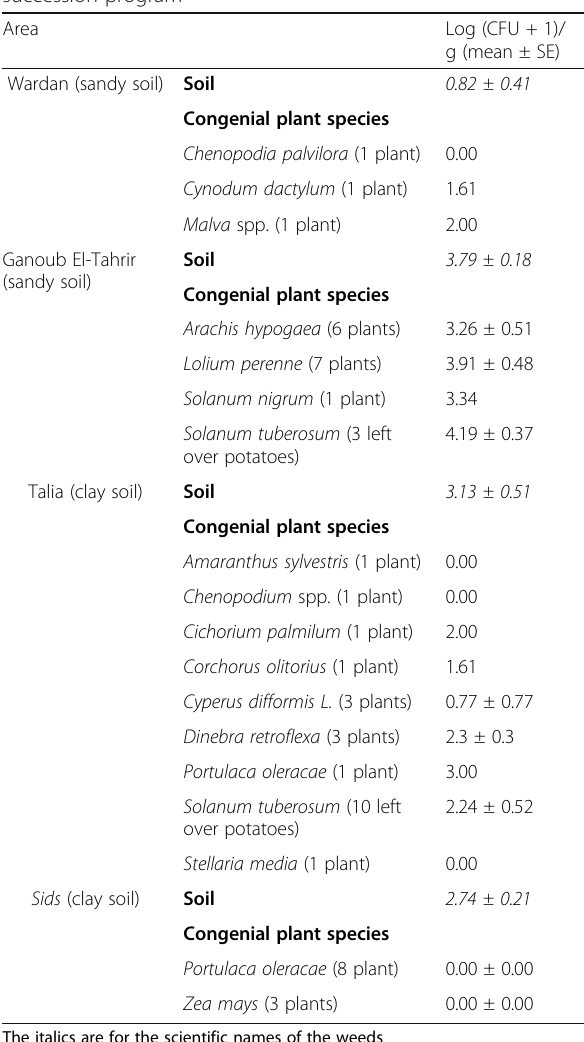
Table 4 Densities of Ralstonia solanacearum in soil and in plant tissues of congenial plant species prior starting the crop succession